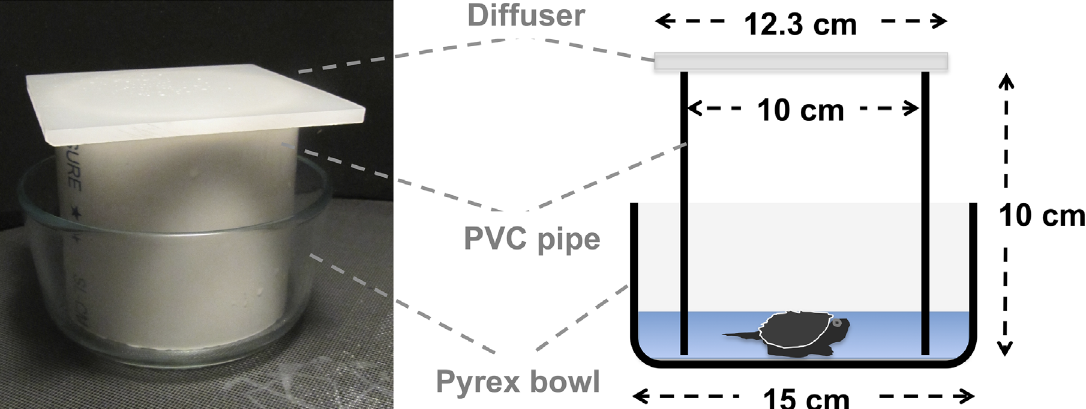
Fig 2. The experimental chamber. Turtles were tested in a Pyrex bowl with water that was ~1 cm deep so the turtle ’ s shell was not completely submerged. The Pyrex bowl, PVC surround, and overhead diffuser provided uniform visual